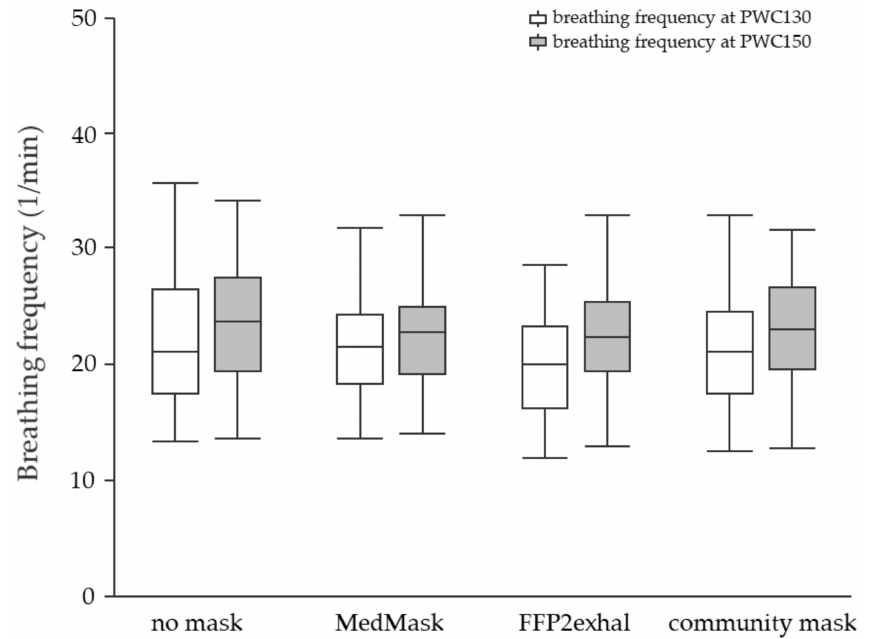
Figure 6. Breathing frequency at the heart rate of 130 and 150 beats per minute using different face masks. Grey shaded boxplots represent breathing frequency at PWC150. PWC, physical working capacity; MedMask, medical face mask; FFP2exhal, filtering facepiece with exhalation valve. Subjective responses at PWC130 and PWC150: The perceived respiratory effort was higher when masks were worn (Figure 7). The mean difference between the control condition and the MedMask was 0.6 points (CI 0.3 to 0.9, p < 0.0001). In comparison to not using a face mask, the community mask and FFP2exhal led to a mean increase of 0.8 (CI